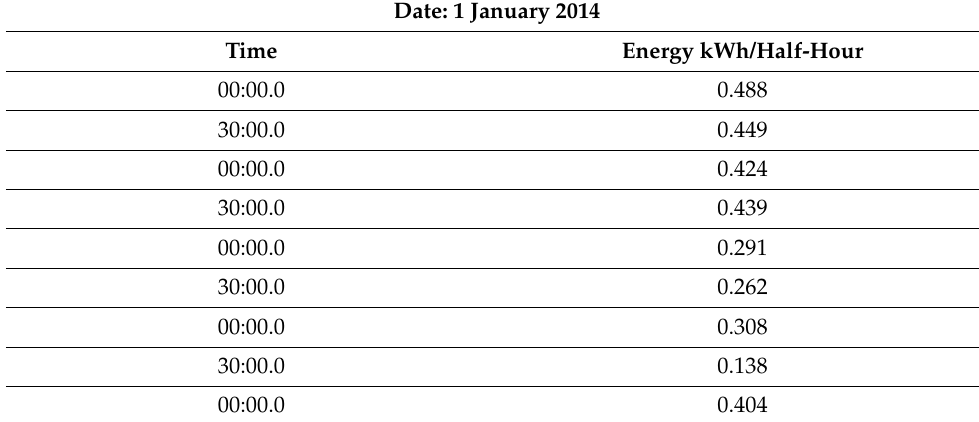
Table 3. A sample of the Smart Grid dataset.